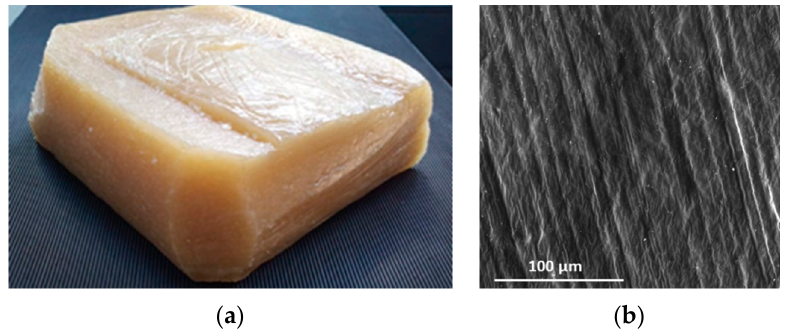
Figure A1. ( a ) Image of gum NBR (PERBUNAN ® 3965 F) delivered as bale; ( b ) scanning electron microscope (SEM) image of an exemplary compression molded sample ( ∅ = 8 mm, thickness = 1 mm) of gum NBR.